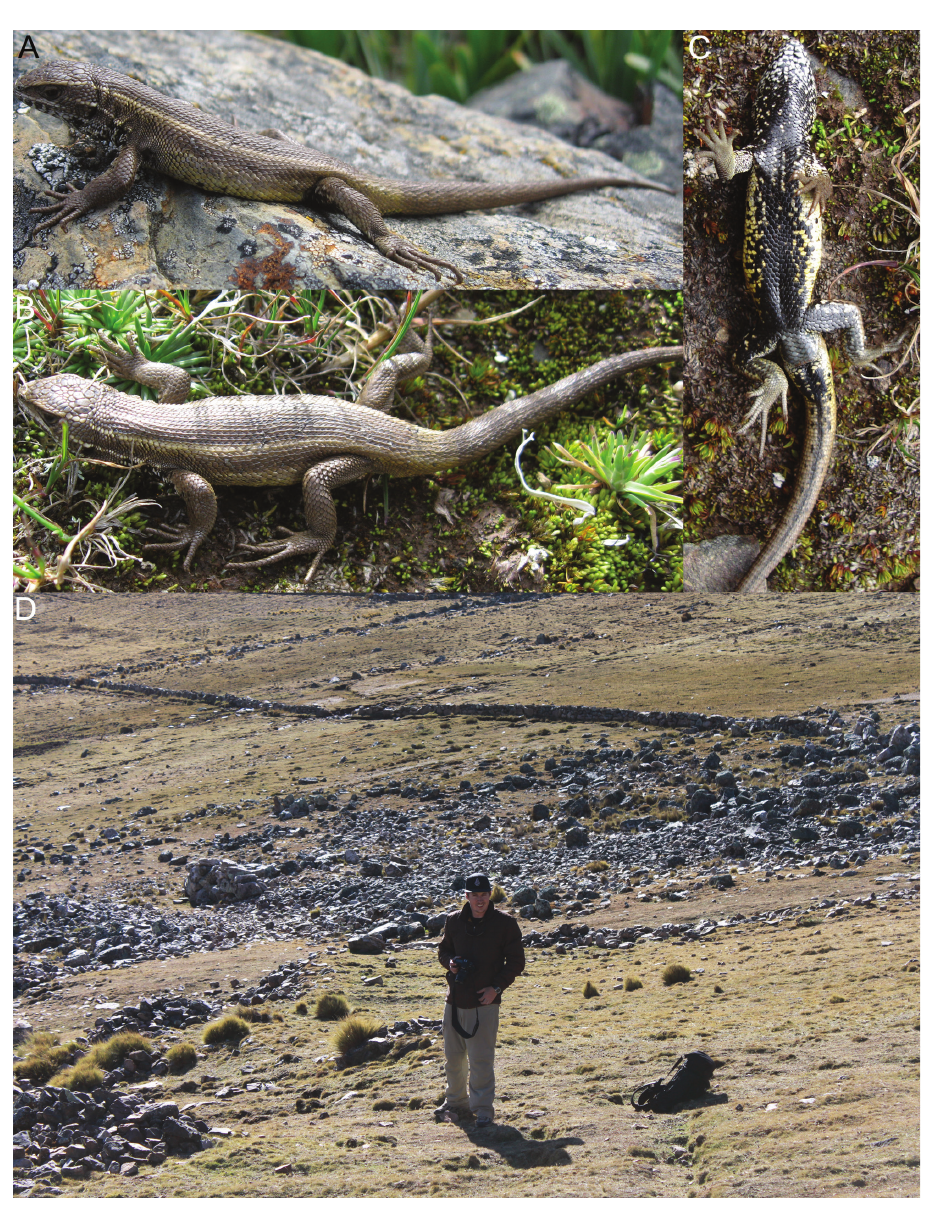
Figure 9. Lateral ( a ) dorsal ( B ) and ventral ( C ) views of the holotype of Liolaemus pachacutec sp. n. ( D ) Habitat of L. large as preocular. Mental in contact with four scales: first infralabials (on each side) and two enlarged chin shields. Chin shields forming a longitudinal row of four en- larged scales separated one from the other by six smaller scales. Scales of throat round, flat, and imbricate. Twenty-two gulars between auditory meatus. Longitudinal neck